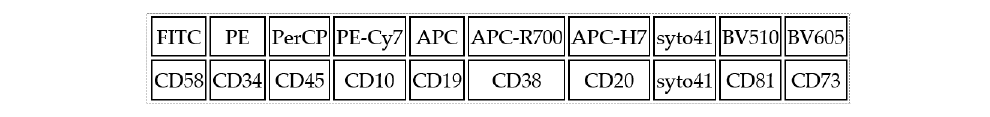
Panel B. For BCP-ALL, ten-color tubes: